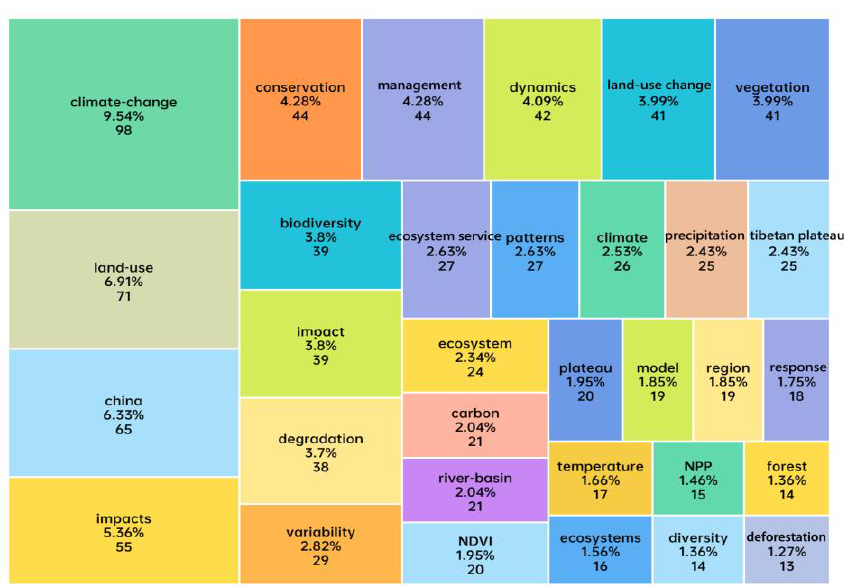
Figure A1. High-frequency keywords and their occurrence frequency in studies considering the ecological and environmental effects of land use and cover changes (LUCC) on the Qinghai – Tibetan Plateau (QTP). Note: NDVI = Normalized Difference Vegetation Index, NPP = Net Primary Productivity.